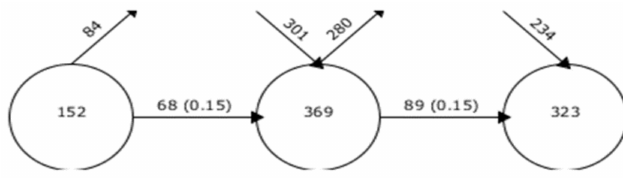
Figure 7. Overlapping graph of keywords from 2012 to